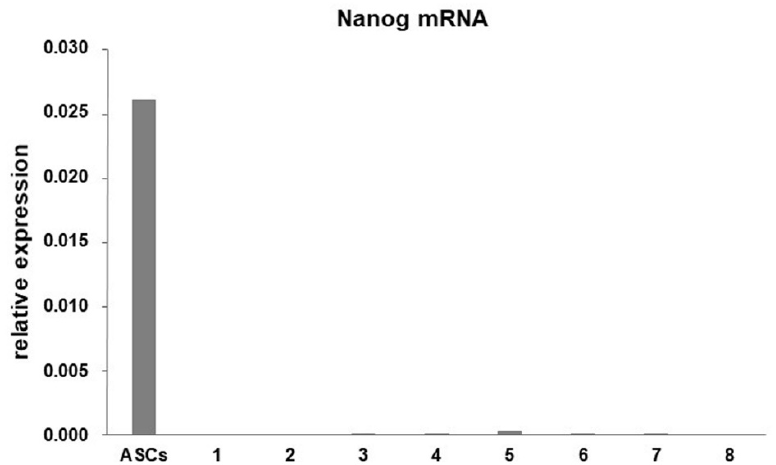
Figure 2. Bar graphs showing mRNA levels for Nanog in adipose tissue-derived stem cells (ASCs) and the eight cell cultures of tenocytes assessed by real-time PCR. Data were normalized on Glyceraldehyde 3-phosphate dehydrogenase (GAPDH) gene expression.